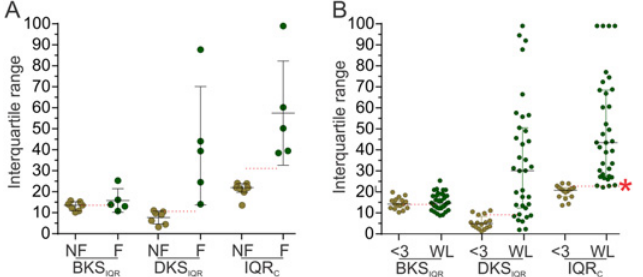
Fig 2. The interquartile range of bradykinesia and dyskinesia scores in fluctuators and non fluctuators. A. The BKS IQR , DKS IQR and IQR C of fluctuators (F and olive colour) and non fluctuating (NF